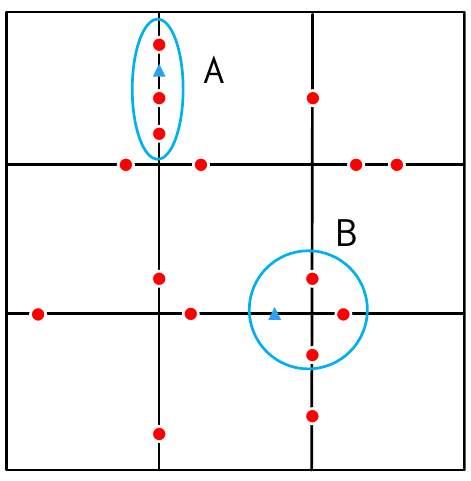
Figure 3. Location privacy protection based on road